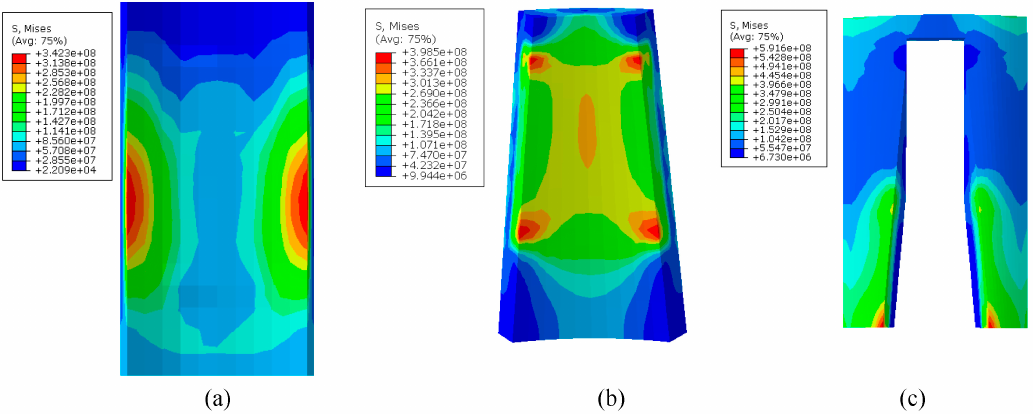
Figure 7. Von-Mises stress distribution of ( a ) casing, ( b ) slip, and ( c ) slip-seat.